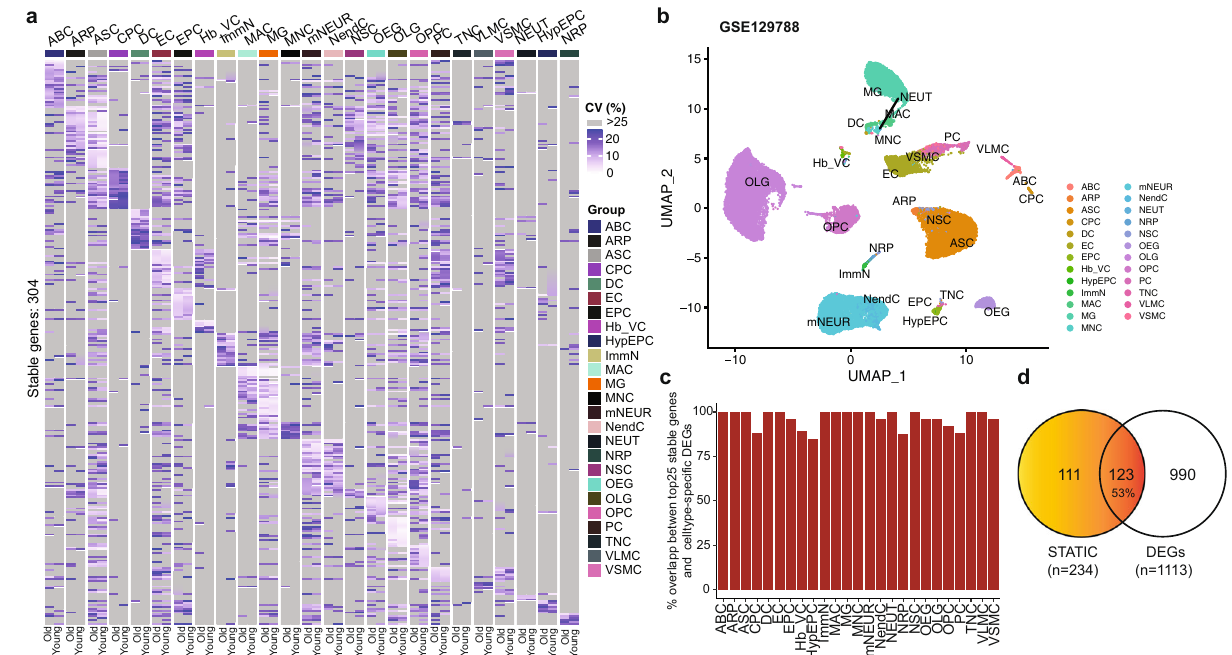
Fig. 5 | Properties of 304 STATIC genes of mouse brain tissue. a Heatmap of coef fi cient of variation (CV) of the 304 stable across time in cell-types (STATIC) genes that were identi fi ed from 25 cell types in the scRNA-seq data of a mouse brain study (GSE129788 36 ). The CVs were evaluated based on pseudo-bulk intensities in brain tissues from either n =8 young or n =8 old mice. b Uniform ManifoldApproximationandProjection(UMAP)usingonlythe304STATICgenes as input features (sUMAP) on the same scRNA-seq data. Cells are labeled as in the original study. c Percentage of top STATIC genes that overlap with cell-type